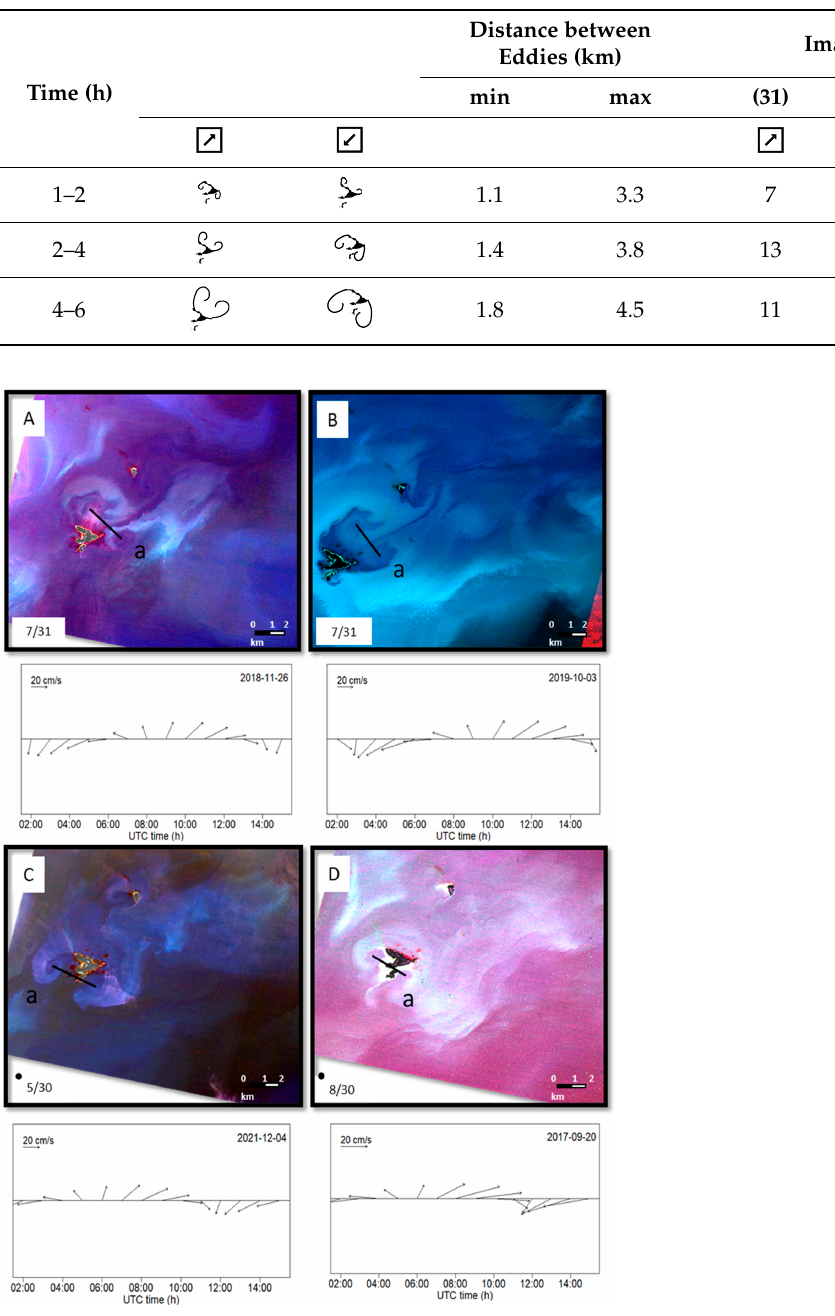
Figure 5. Eddies behind Viana island. ( A ) Eddy north of Viana Is., after 2 h of SE tide current. ( B ) Eddy north of Viana Is., after 1 h of ESE tidal current. ( C ) Eddy south of Viana Is., after 5 h of SW tidal current. ( D ) Eddy south of Viana Is., after 4 h of WSW tidal current. Black lines indicate how the structures were measured, being (a) distance between the eddies’ centers. Numbers in the lower left corner represent the number of scenes showing this particular structure (linked with Table 3). The arrow time series below each image represents the tidal current velocities 12 h prior to the acquisition of the image as extracted from TPXO data at the locations marked on the corresponding